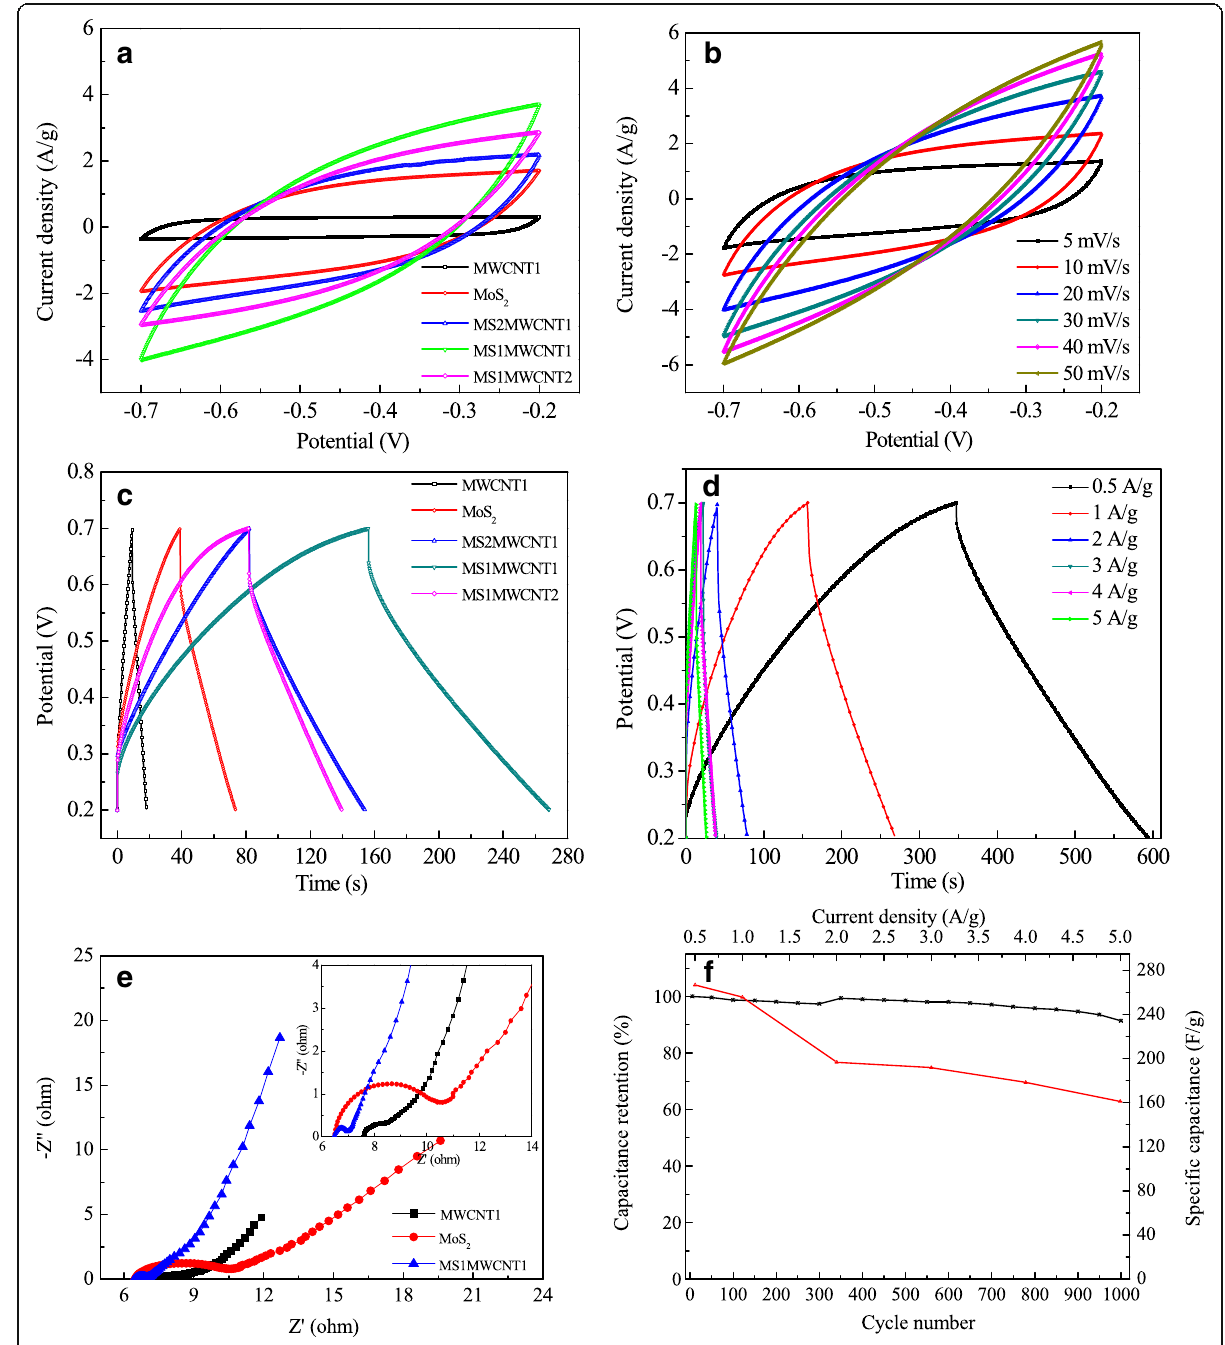
Fig. 3 CV curves for the MoS 2 |MWCNTs electrodes with different mole ratios of MoS 2 and MWCNTs at 20 mV/s ( a ), CV curves of MS1MWCNT1 at different scan speeds ( b ), GCD curves for the different electrodes at 1 A/g ( c ), GCD curves of MS1MWCNT1 with different current densities ( d ), EIS curves for the various electrodes ( e ), the stability after 1000 cycles CVs (black line), and specific capacitance at different current densities (red line) of the MS1MWCNT1 electrode ( f